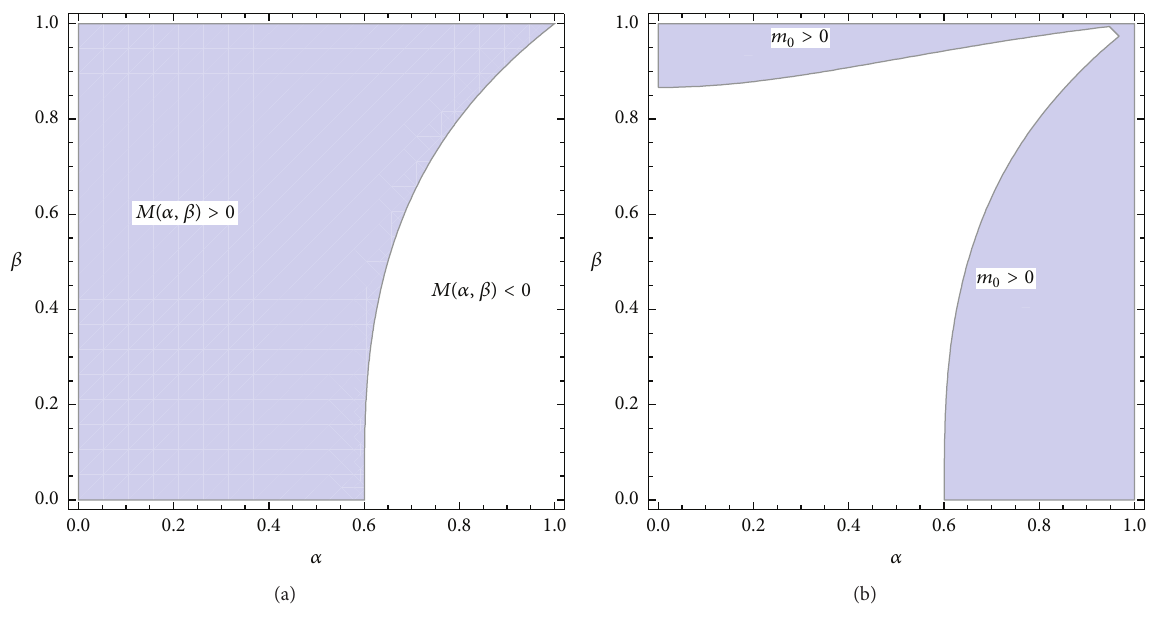
Figure 3: (a) 𝑀 > 0 (colored) (b) 𝑚 0 > 0 (colored).